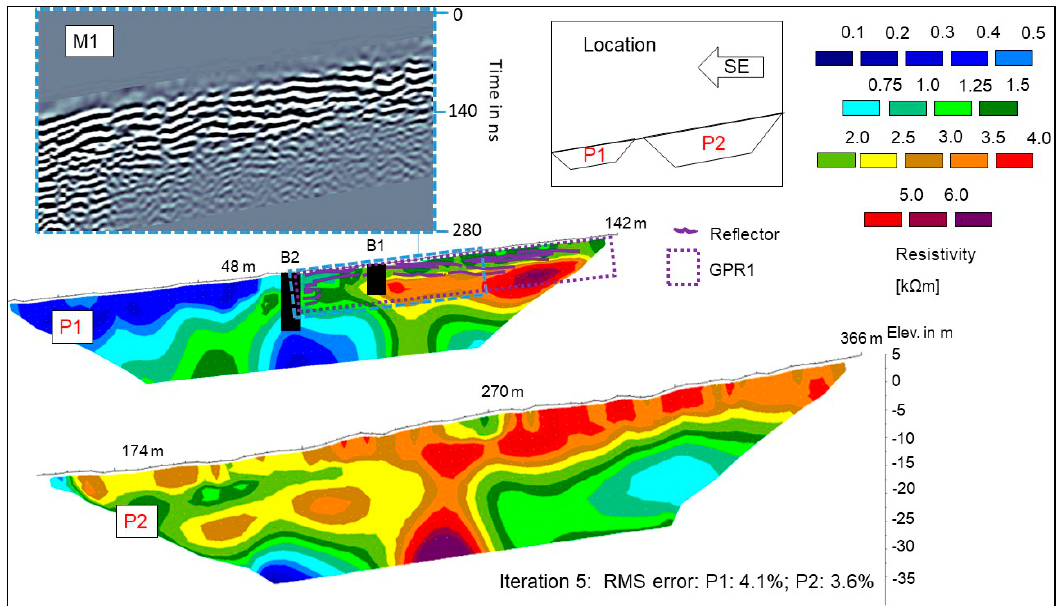
Figure 4. Geophysical surveys in the catchment area of "Thranenbruch".